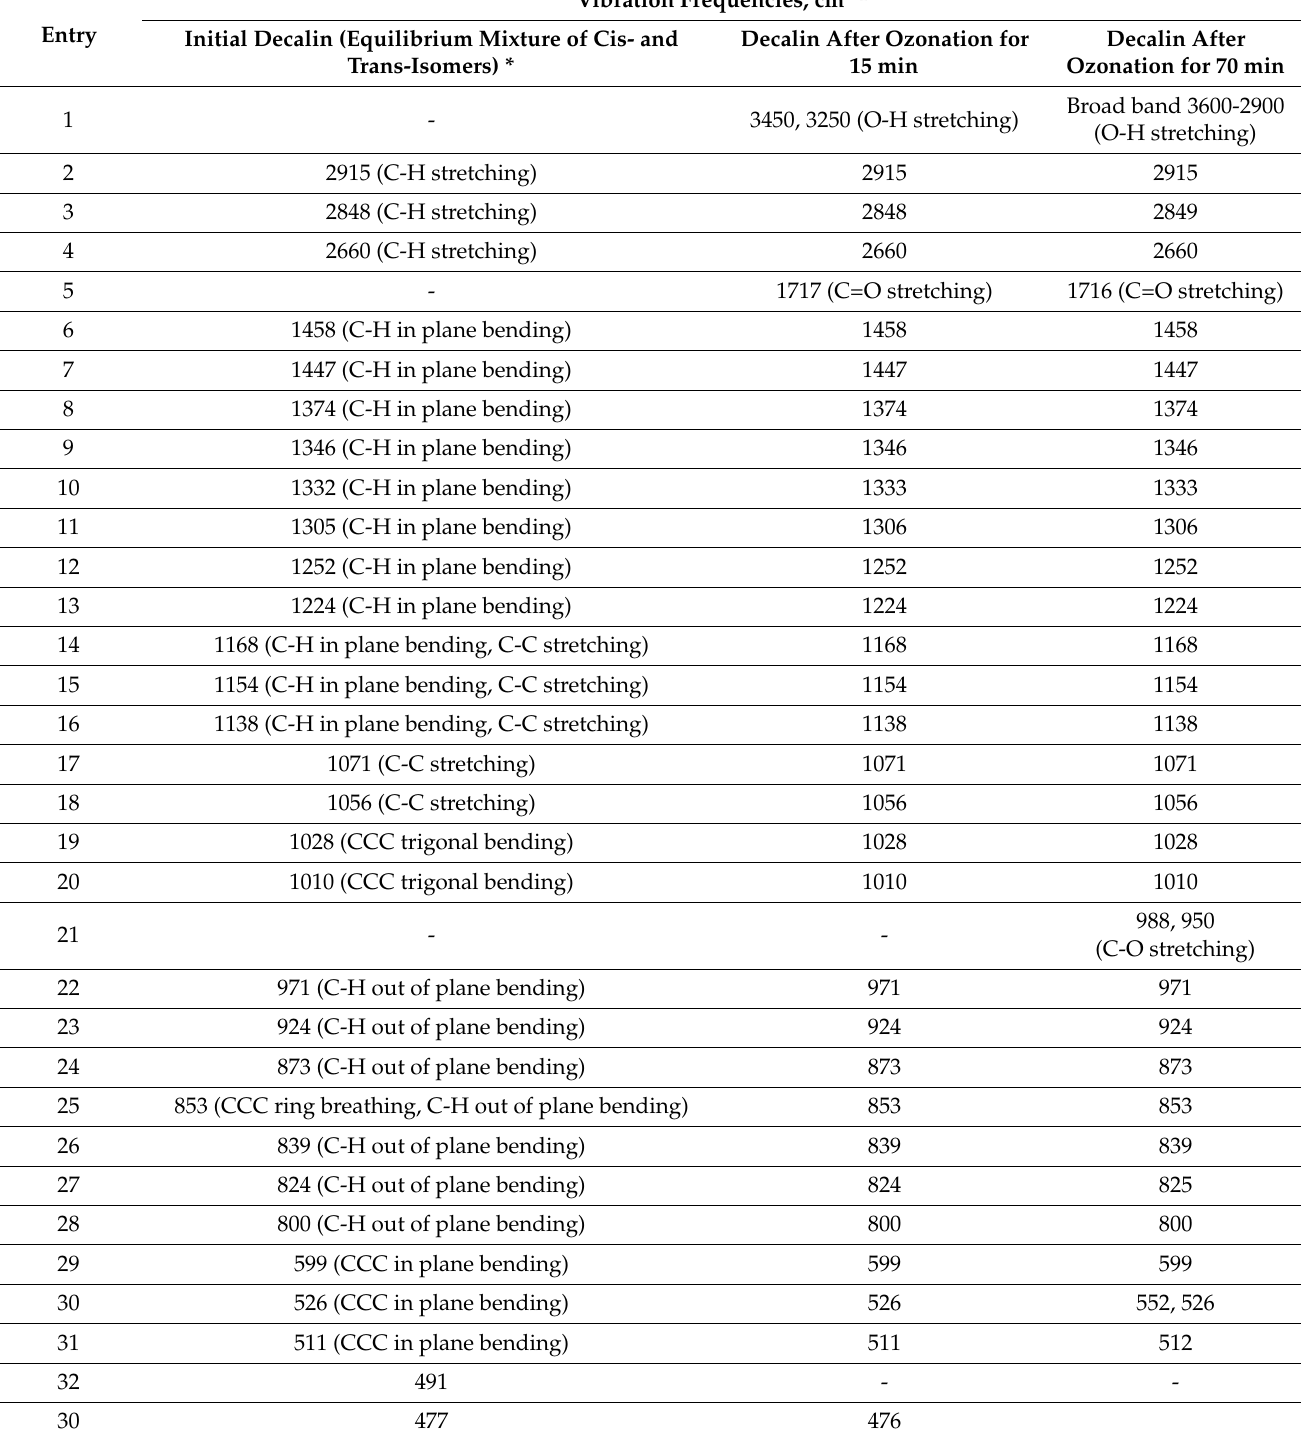
of oxygen-containing bonds, namely carboxyl groups, which indicates decalin oxidation by ozone. Table 1. Assignment of absorption bands in IR spectra of cis and trans-decalins, initial decalin (equilibrium mixture of cis and trans-isomers) and decalin after ozonation for 15 and 70 min. Vibration Frequencies, cm − 1 Entry Initial Decalin (Equilibrium Mixture of Cis- and Trans-Isomers)